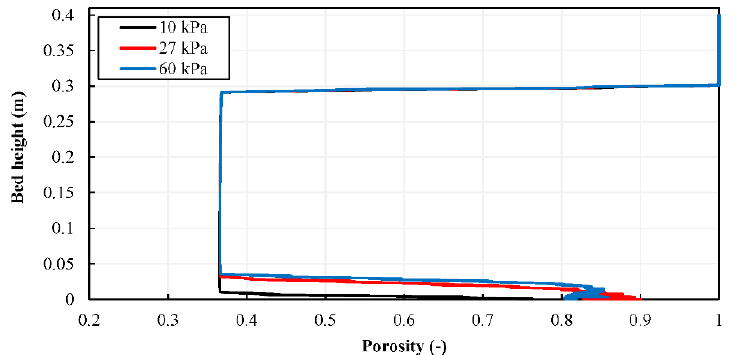
Figure 4. Porosity distribution along the bed centerline for upstream pressure values 10, 27, and 60 kPa.